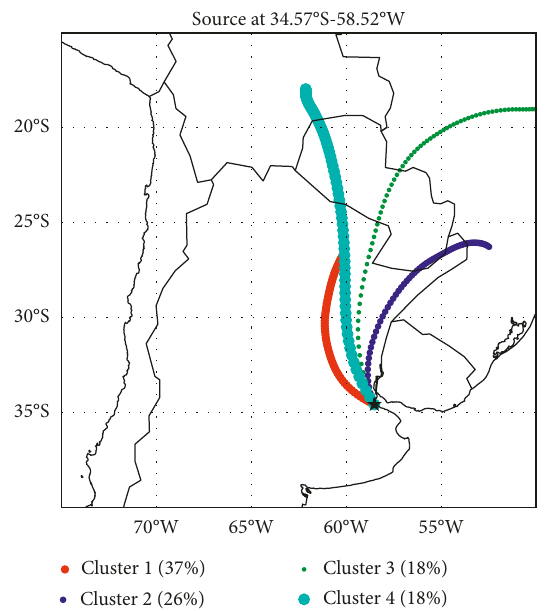
Figure 8: Cluster mean trajectories arriving at CEILAP-BA during the selected days. Trajectory widths indicate variability in the spatial path of each cluster. The percentage contribution of each cluster is also indicated between